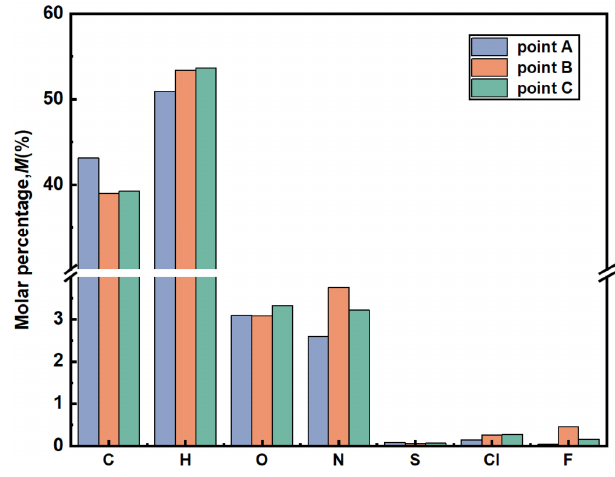
Figure 9. The element percentage of compounds in tar.